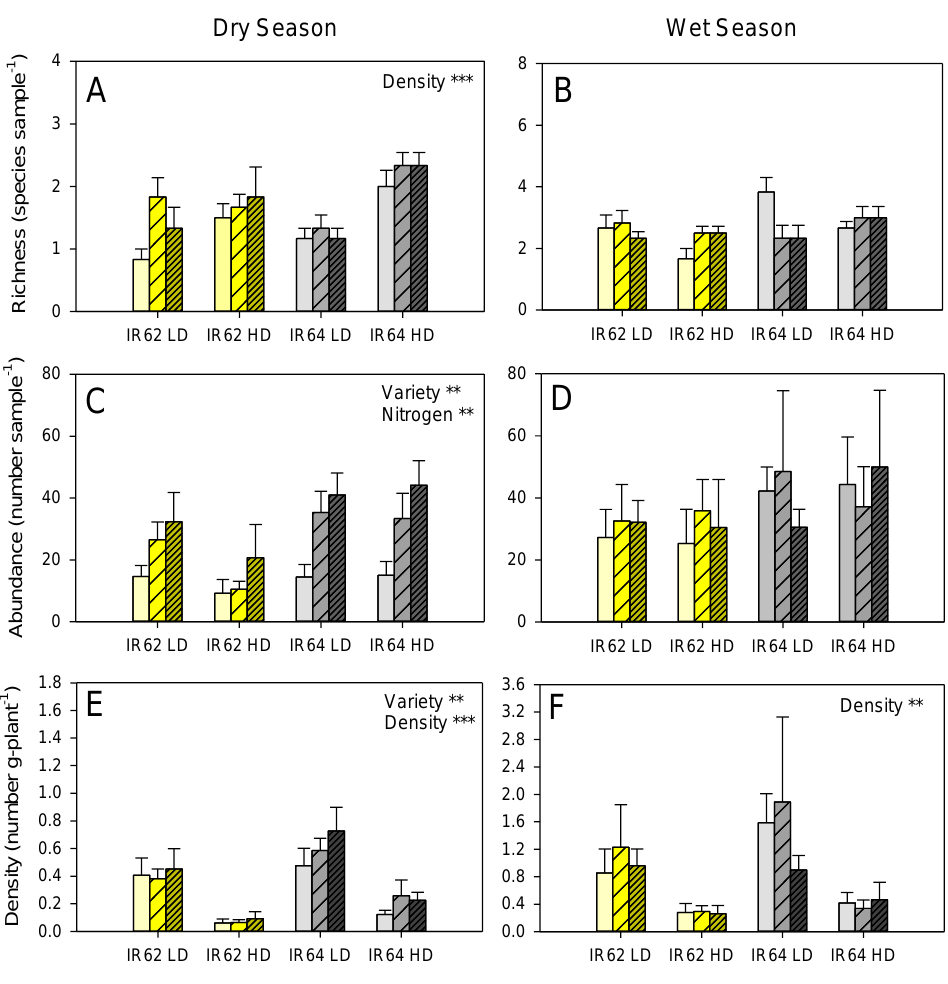
Figure 1. Species richness ( A , B ), abundance ( C , D ), and density ( E , F ) of planthoppers (all species combined—see Table S1) in rice plots with resistant (IR62: yellow bars) and susceptible (IR64: grey bars) rice transplanted at low (LD) and high (HD) densities under varying nitrogen fertilizer treat- ments. Nitrogen was applied at 0 Kg ha − 1 (open bars), 60 Kg ha − 1 (hatched bars), and 150 Kg ha − 1 (densely-hatched bars). Factors that significantly affected planthopper parameters are presented with significance levels as ** p ≤ 0.01 and *** p ≤ 0.005. Sampling was conducted during the dry ( A , C , E ) and wet ( B , D , F ) seasons using blow-vac samplers. Standard errors are indicated ( N = 6). High transplanting density was associated with a greater richness (F 1,71 = 17.77, p < 0.001) of planthopper species during the DS sampling and lower planthopper densities in both the DS (F 1,71 = 42.91, p < 0.001) and WS (F 1,71 = 8.93, p = 0.009) (Figure 1A,B). Planthop- pers were more abundant (F 1,71 = 9.10, p = 0.009) and attained higher densities (F 1,71 = 8.25, p = 0.012) on the susceptible variety during the DS sampling, but not the WS (Figure 1C- F). Planthopper abundance increased linearly with increasing nitrogen levels (F 3,71 = 6.96, p = 0.013; linear contrast = 0.001), but the effect was not apparent for planthopper densities, and nitrogen effects were not apparent during WS sampling (Figure 1C-F). During the DS, S. furcifera was more abundant on IR64 (F 1,71 = 8.73, p = 0.011), in low- density plots (F 1,71 = 14.15, p = 0.002) and in high-nitrogen plots (F 2,71 = 7.09, p = 0.012). The abundance of N. lugens was not affected by variety or nitrogen level, but was significantly higher in the high-density plots (F 1,71 = 62.51, p < 0.001). There were no significant variety, nitrogen, or density effects on either species during the WS sampling (Table S1). Leafhopper captures were lower in the DS sample. At the time of DS sampling, the species richness (F 1,71 = 5.70, p = 0.031), abundance (F 1,71 = 34.94, p < 0.001) and densities (F 1,71 = 41.32, p < 0.001) of leafhoppers were all lower on IR62 than IR64 (Figure 2). Leafhopper densities were higher in low-density plots (F 1,71 = 12.36, p = 0.003) and declined linearly with increasing nitrogen (F 2,71 = 4.13, p = 0.049: linear contrast, p < 0.001). There were no significant variety or nitrogen effects on leafhopper richness, abundance or density at the time of WS sampling. However, leafhopper densities were higher in the low-density plots (F 1,71 = 27.52, p < 0.001) during the WS (Figure 2). The DS abundance of N. virescens was